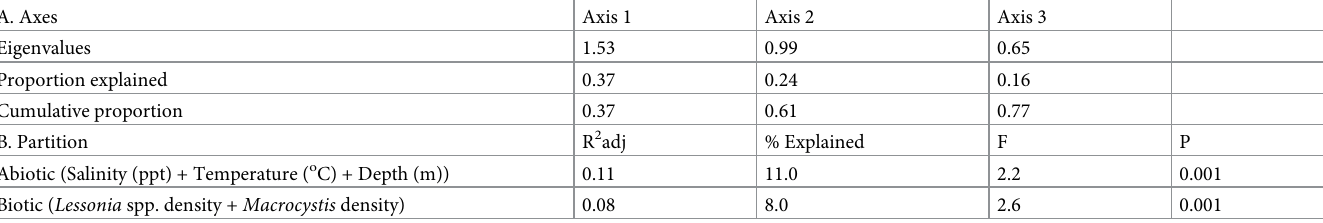
Table 3. Results of Redundancy Analysis (RDA). A. RDA on sqrt-transformed data on fish abundance with environmental variables (salinity (ppt), temperature ( o C), depth (m), Macrocystis pyrifera stipe density, and Lessonia spp. stipe density). B. RDA with variance partition performed to quantify the contribution of abiotic and biotic factors.